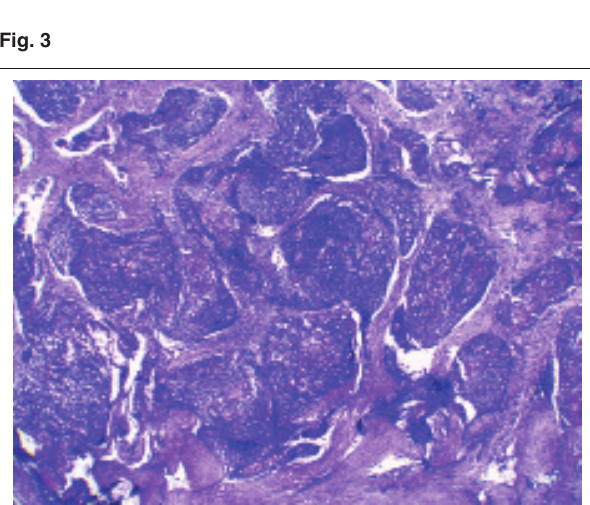
Prominent lobular architecture of neoplastic proliferation of mixture of epithelial cells and lymphocytes surrounded by fibrous tissue (H and E ×100).